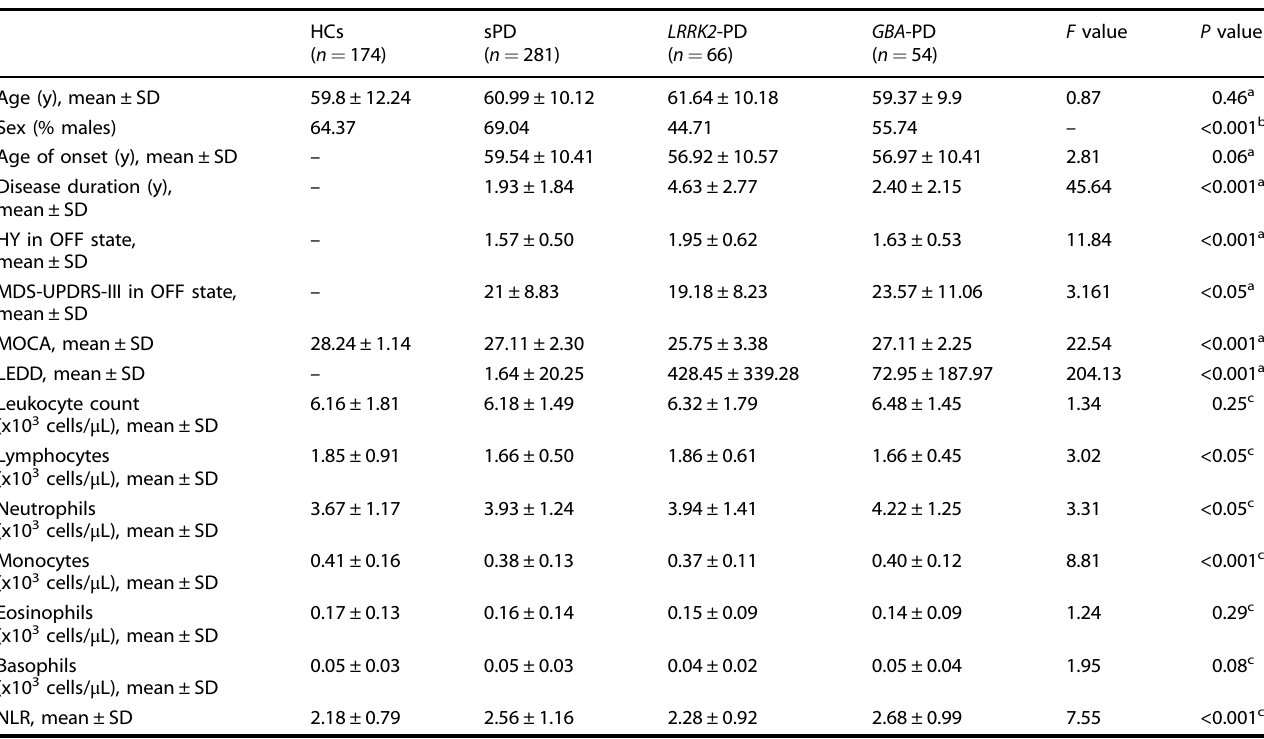
Table 3. Demographic and clinical data, and peripheral immune response of healthy controls and Parkinson ’ s disease genetic cohorts of the PPMI replication cohort.